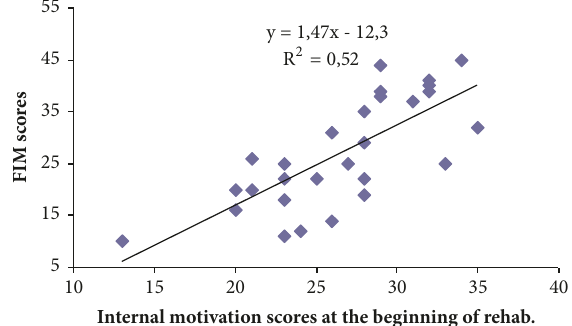
Figure 3: The relationship between internal motivation scores at the beginning of the rehabilitation and change of FIM scores in the course of